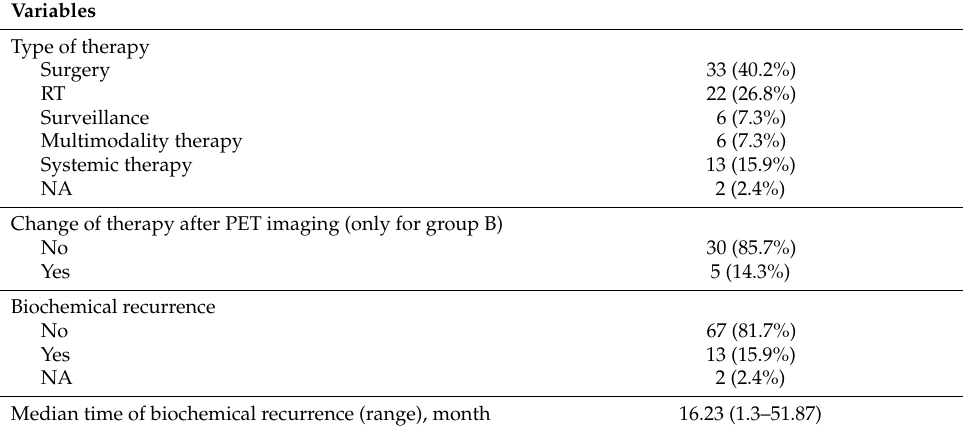
Table 2. Patients’ therapy selection and